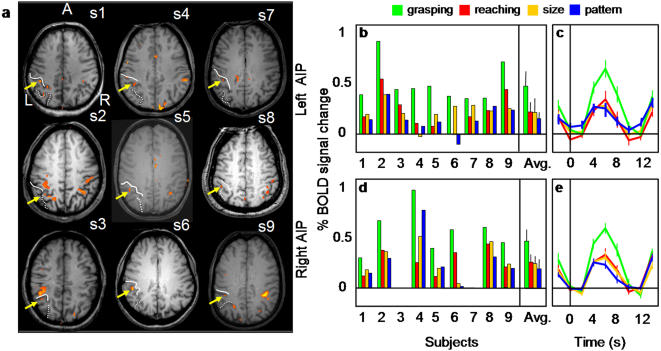
Individual activation maps and % BOLD signal change (% BSC) in the anterior intraparietal (AIP) sulcus for Experiment 1.a) The exact position of the left AIP localized by comparing grasping versus reaching is shown in the most clear transverse slice for each of the nine subjects. In each subject, AIP (highlighted by a yellow arrow) lay at the junction of the anterior end of the intraparietal sulcus (dotted line) and the inferior segment of the postcentral sulcus (PCS - plain line). Note that in five of the nine subjects AIP is also visible in the right hemisphere. b,d) Bar graphs display the magnitude of peak activation in % BSC in each experimental condition at the level of single subject and group average (the rightmost bars) for left and right AIP. For two of the nine subjects, the peak activation was not computed in the left AIP because no activity was found in that area. c,e) Line graphs indicate the event-related averaged time course in % of BSC for the four experimental conditions in the right and left AIP with time zero indicating the onset of the visual stimuli. Both magnitude of peak activation and event-related averaged time courses show that activation for grasping was higher than that for reaching and that the activation associated with size discrimination did not differ from that associated with pattern discrimination. L = left, R = right, P = posterior.